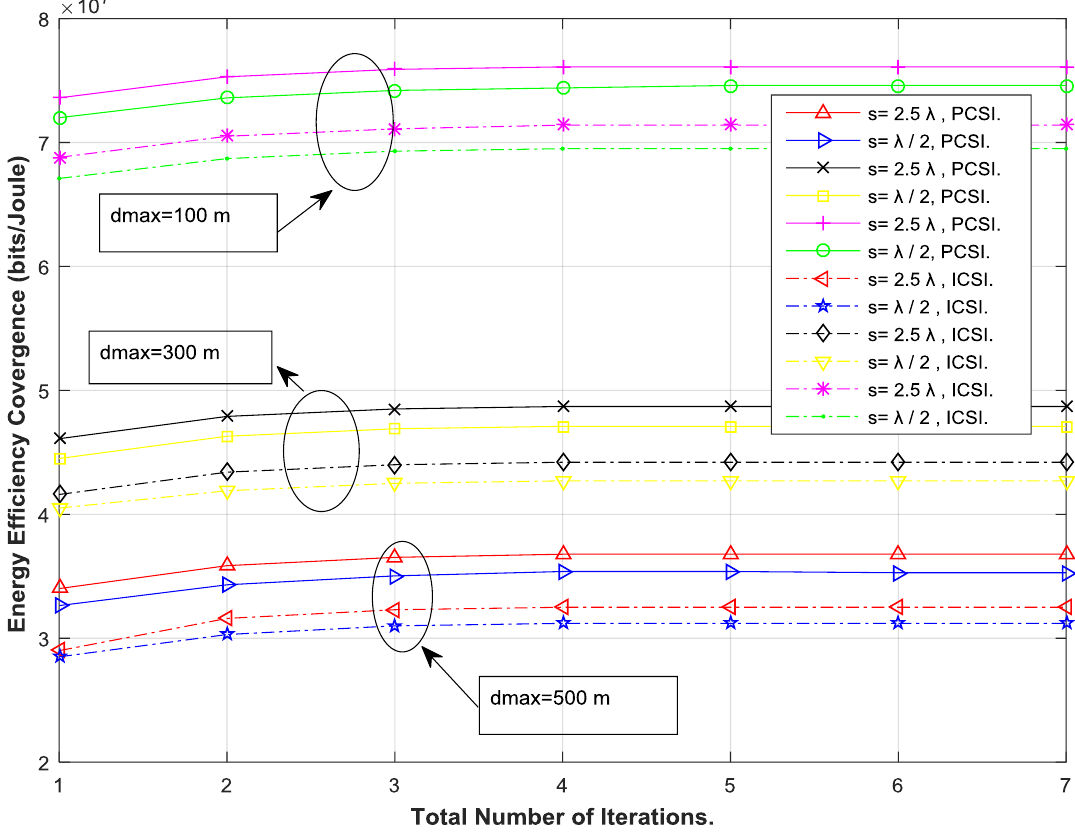
Figure 12. Convergence and the computation Complexity of the domain splitter Algorithm.